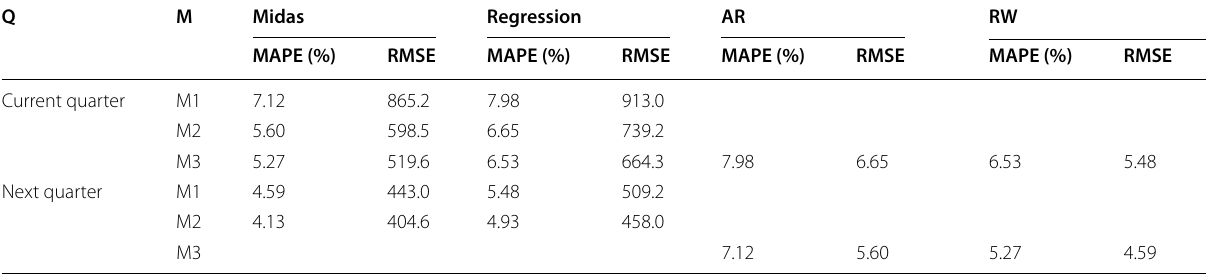
Table 10 MAPE and RMSE loss functions for the export of services models (in nominal values) Q